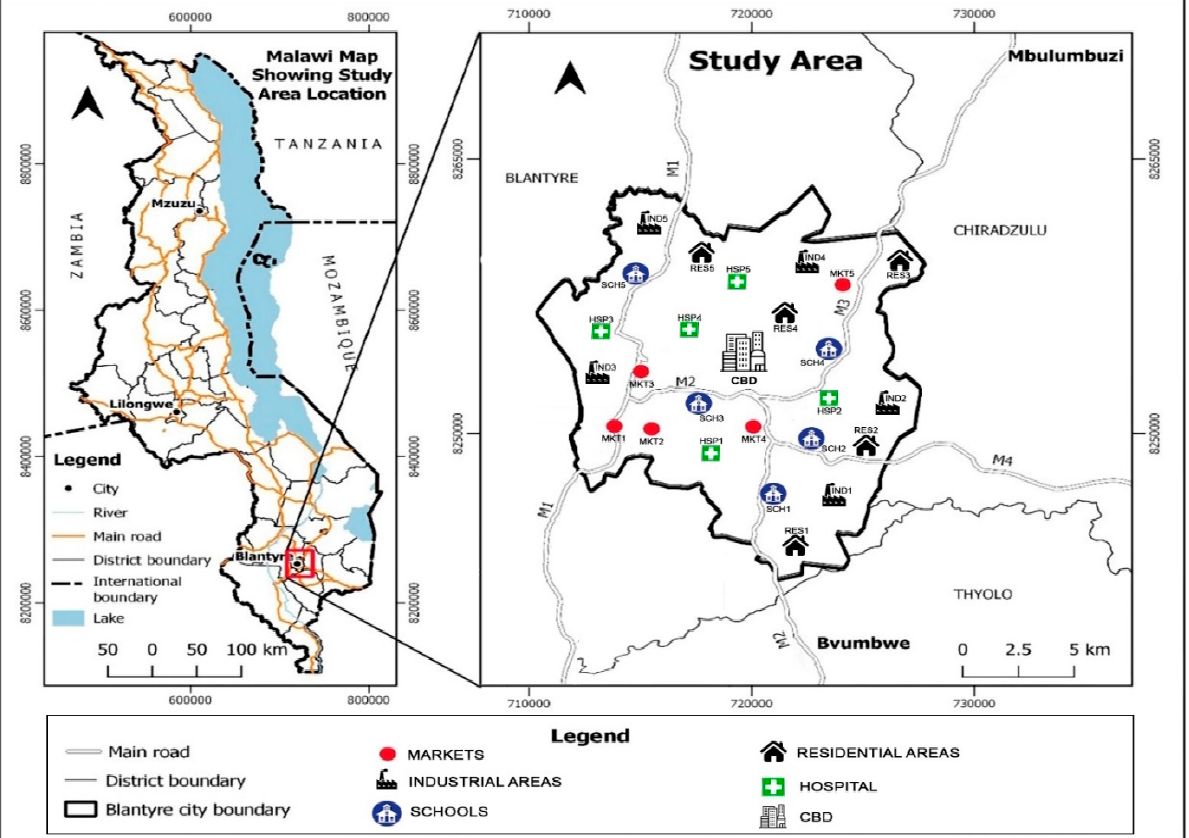
Figure 1. Map of measurement locations in Blantyre, Malawi.